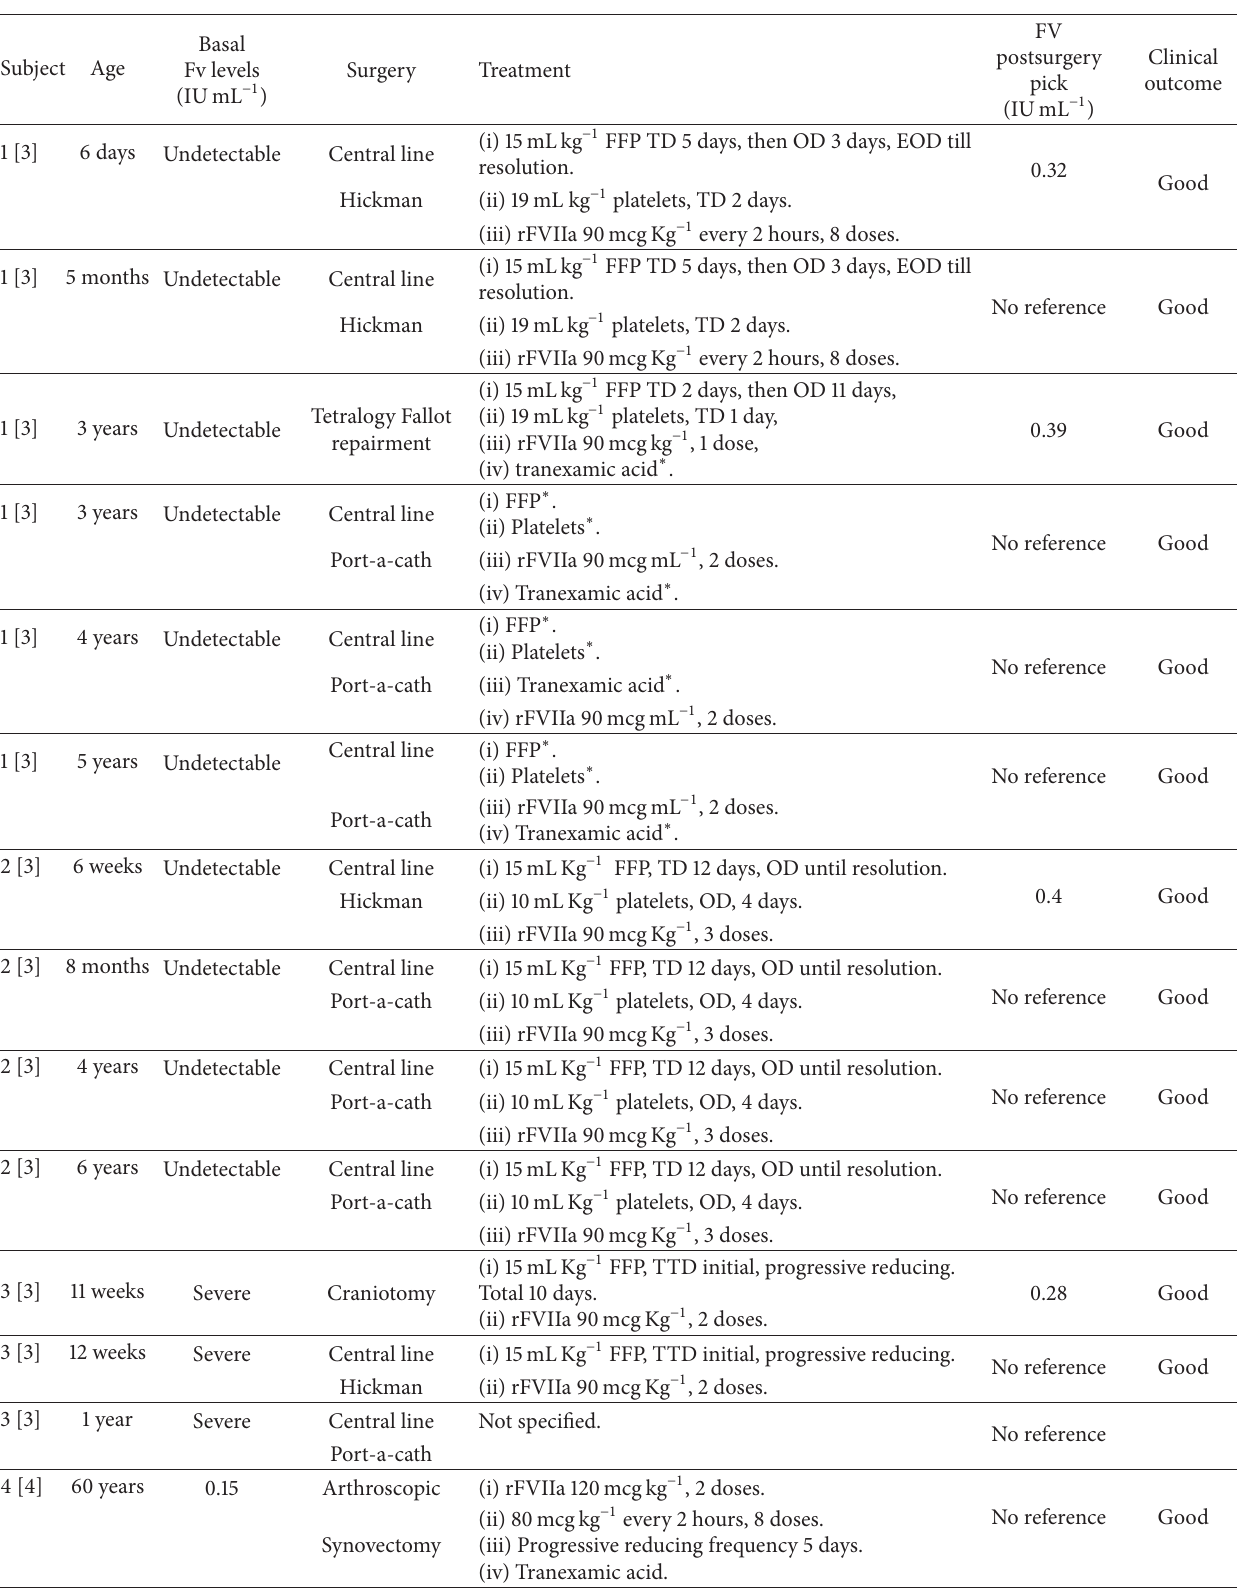
Table 2: FV deficiency surgeries identified in